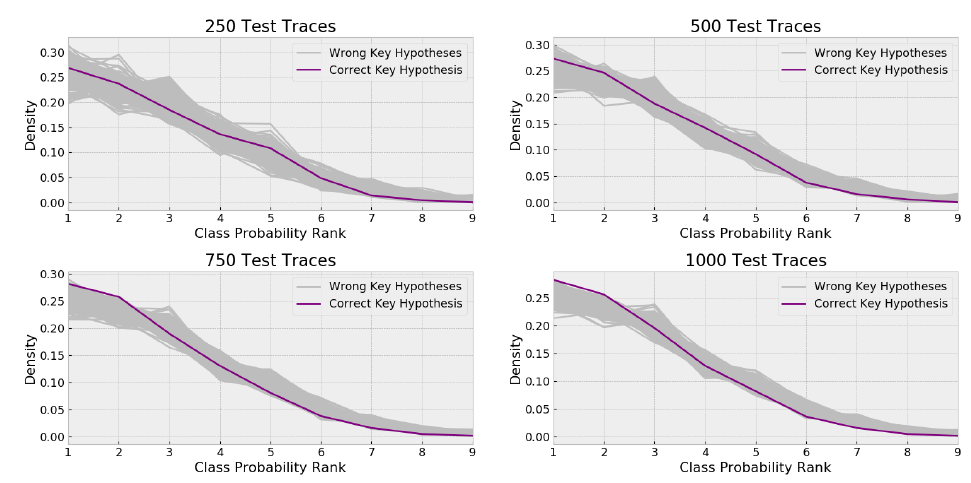
Figure 4: Rank of output class probabilities for the test set by considering correct and incorrect key candidates for different amount of test traces (ASCAD) and MLP.